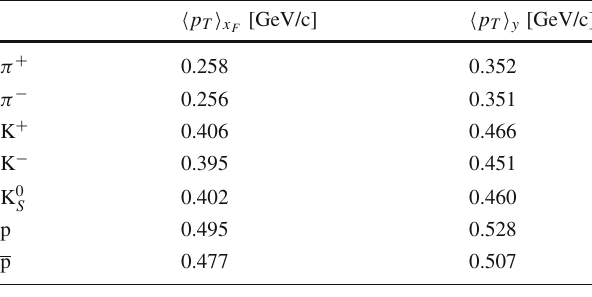
Table 6 (cid:4) p T (cid:5) x for x F = 0 and (cid:4) p T (cid:5) y for y = 0 at F feed-down subtracted data for different particle species